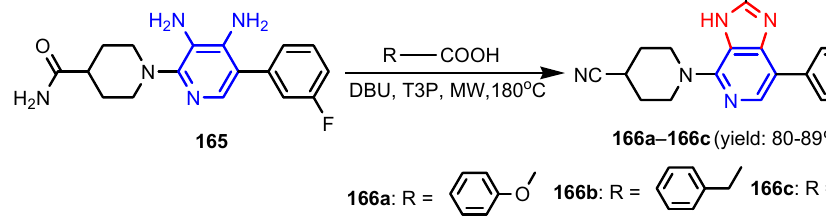
Int. J. Mol. Sci. 2022 , 23 , 5659 24 of 41